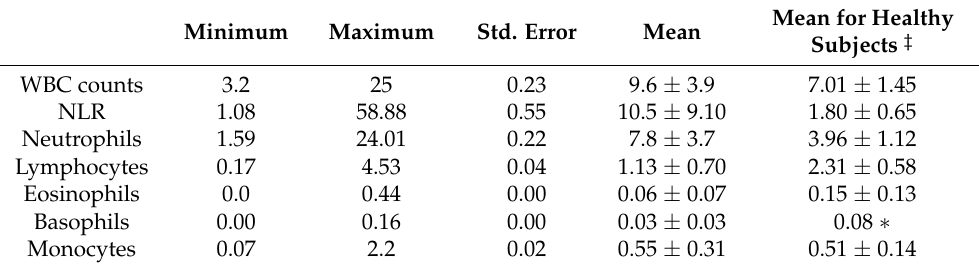
Table 2. Descriptive statistics of NLR, WBC counts, and WBC differential counts of all COVID-19 patients